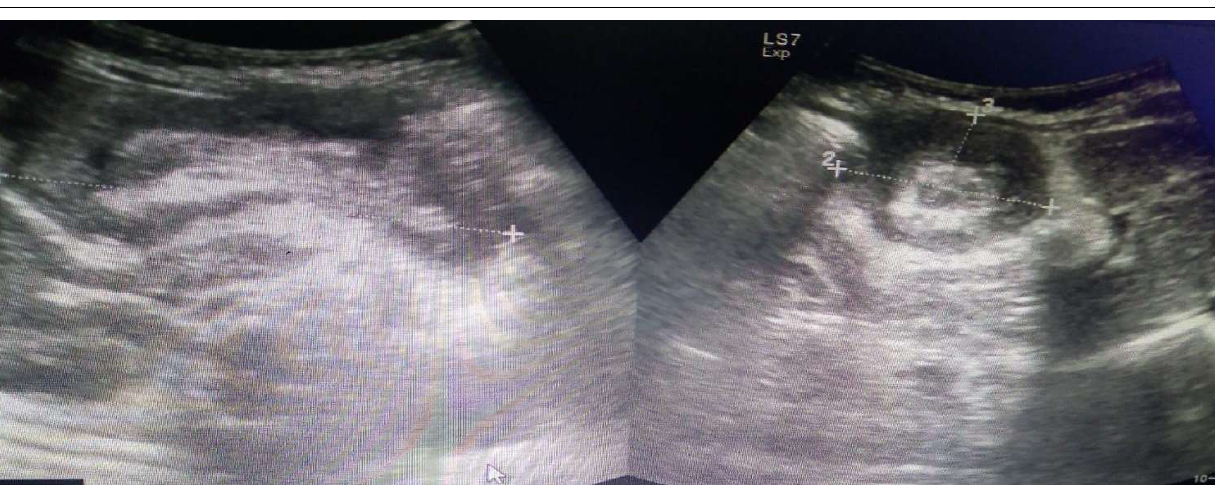
Legend: Target sign of intestinal Intussusception.